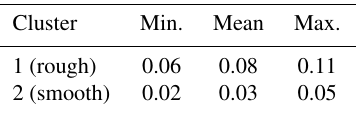
Table 5. Minimum, mean, and maximum values of surface SD for